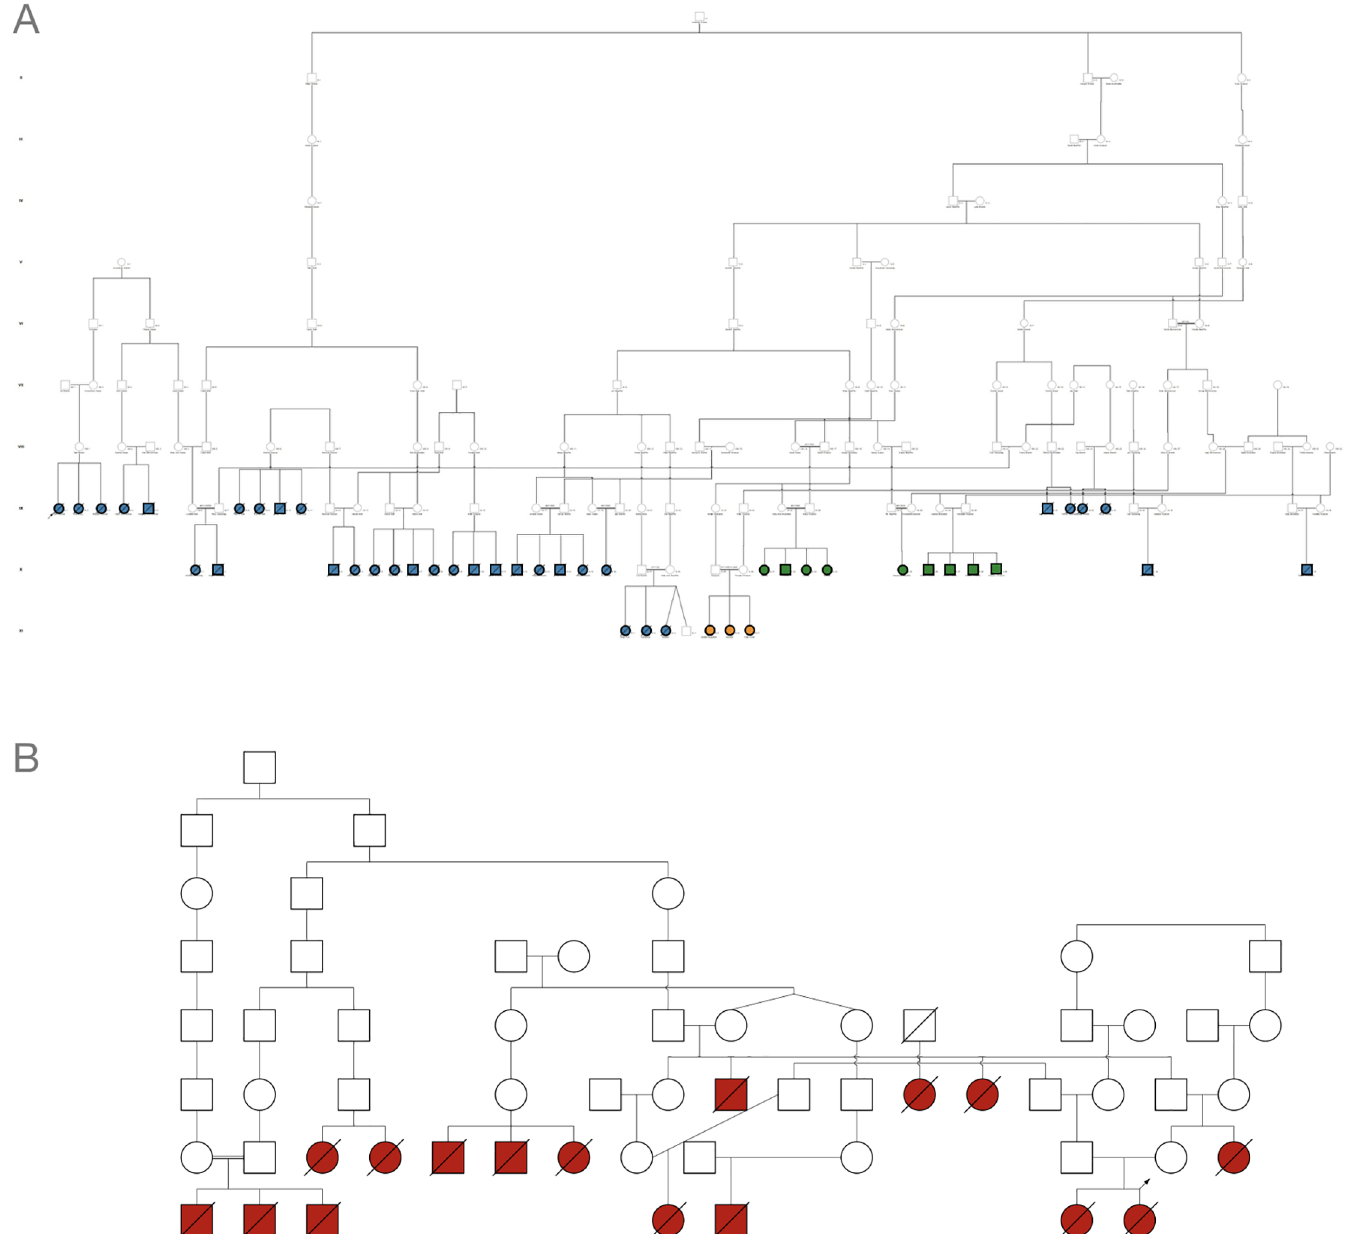
Fig 1. Spinal muscular atrophy in Mennonite and Amish pedigrees. (A) Forty-two Mennonite SMA patients with homozygous deletions of SMN1 traced to a common founder through 11 generations but had variable numbers of SMN2 copies (blue, 2 copies of SMN2; green, 3 copies of SMN2; orange, 4 copies of SMN2 ).(B) Although we could not connect 14 Amish SMA patients using extant genealogical records, all were homozygous for the same SMA haplotype (red, 2 copies of SMN2 ) indicating common ancestry.